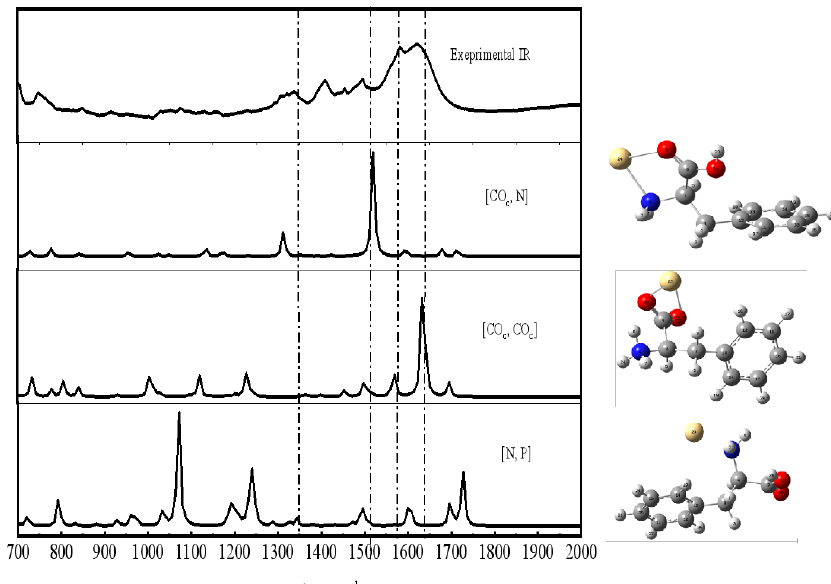
Figure 4. The experimental (upper) and calculated (lower) IR spectra of PheCd 2+ . The gray, red, yellow, blue, and silver balls represent carbon, oxygen, cadmium, nitrogen, and hydrogen atoms, respectively.